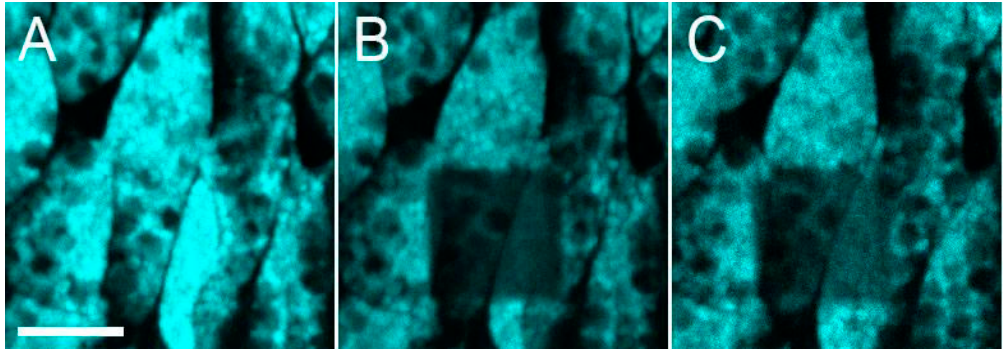
Figure 6. Low mobility of cyan FP-containing vesicles in Clavularia tissues. Cyan fluorescence before photobleaching ( A ); just after photobleaching in a square region ( B ); and 20 min after photobleaching ( C ). Scale bar, − 10 µm.